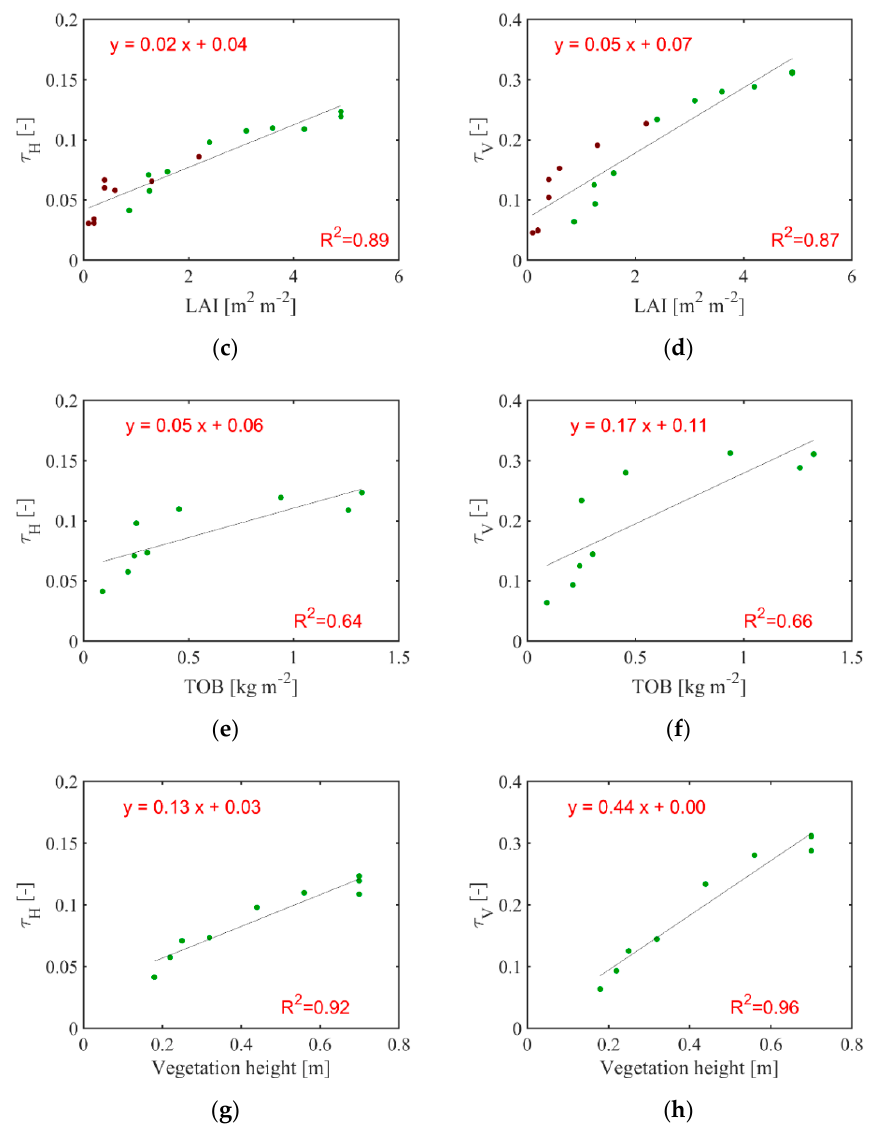
Figure 9. Correlations between the vegetation properties of the winter wheat measured in situ, i.e., VWC ( a , b ), LAI ( c , d ), TOB ( e , f ), and vegetation height ( g,h ), and the retrieved τ from the gridded plot T B data at H ( left panel ) and V polarizations ( right panel ). Green circles indicate the vegetative stages and brown circles indicate the senescence stages of the vegetation.